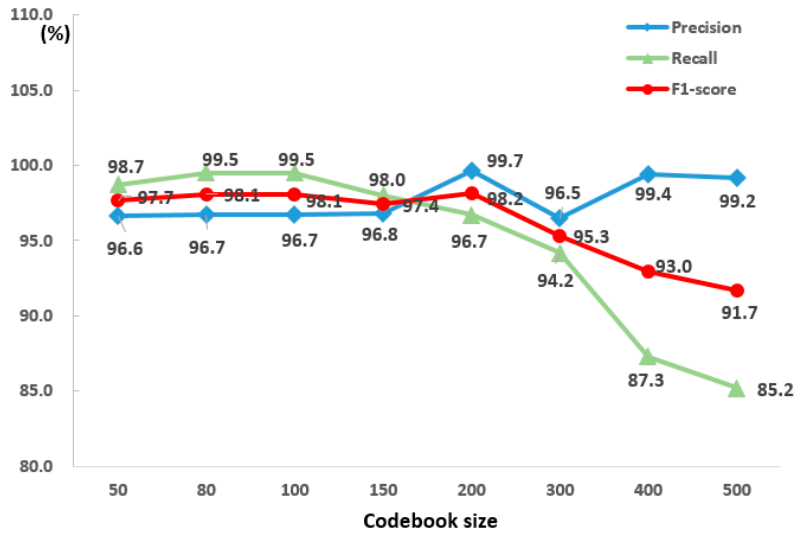
Figure 6. Nine pairs of experimental results to determine the codebook size.